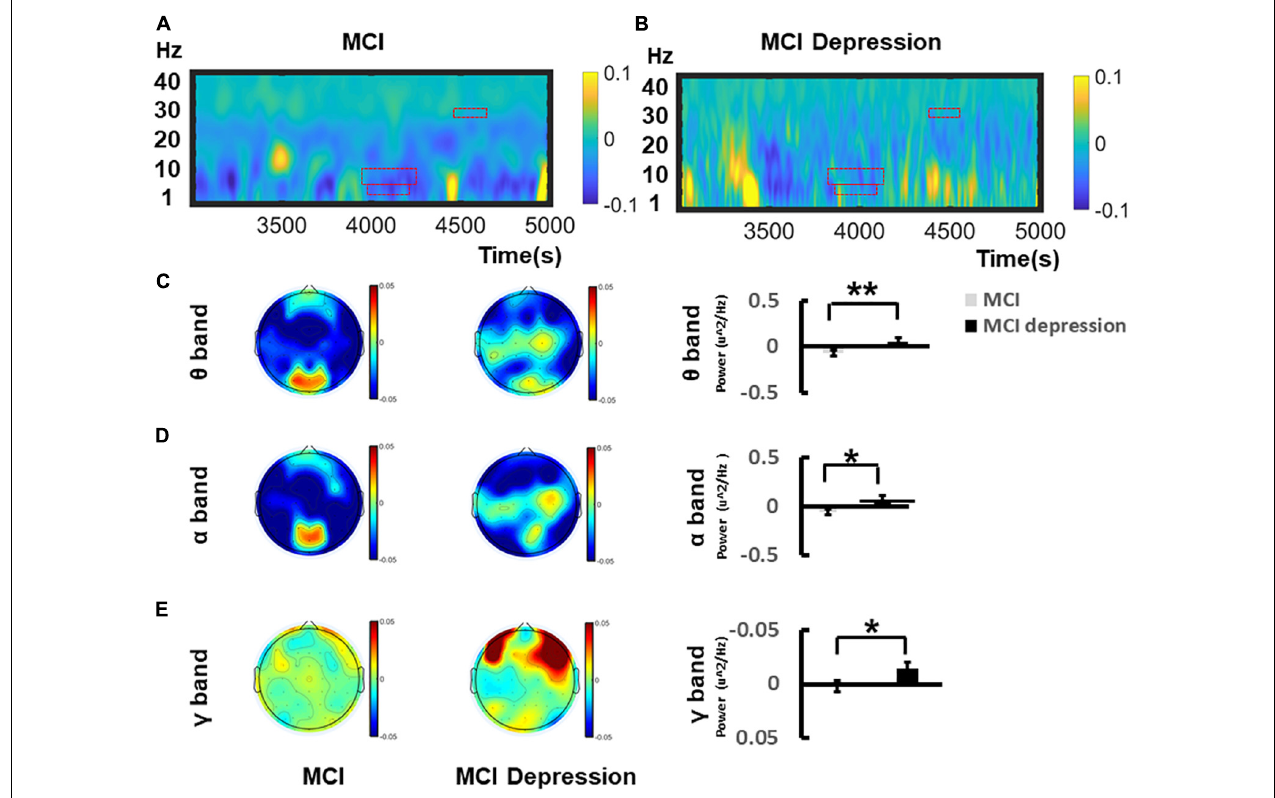
FIGURE 4 | Grand average time–frequency distribution (TFD) over the central lobes during the time window of LPP of Emotion Regulation task. (A) Demonstrates the TFD over the central lobe (CP1/2, CPZ) ranging from (1–40 Hz) during the Emotion Regulation task regarding MCI group. The ROI of TFD were highlight with red frame. (B) Demonstrates the TFD over the central lobe (CP1/2, CPZ) ranging from (1–40 Hz) during the Emotion Regulation task regarding MCI depression group. (C) Illustrates the bar graph differences of ROI of theta oscillation between MCI and MCI depression group. (D) Illustrates the bar graph differences of ROI of